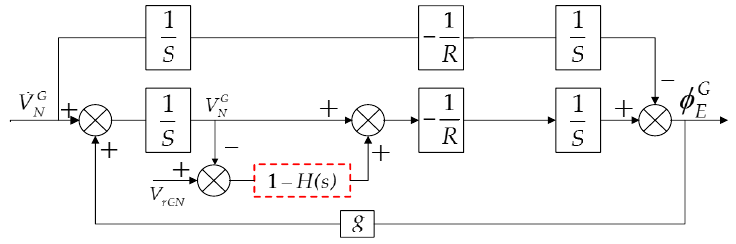
Figure 4. Block diagram of T-DGSINS algorithm.